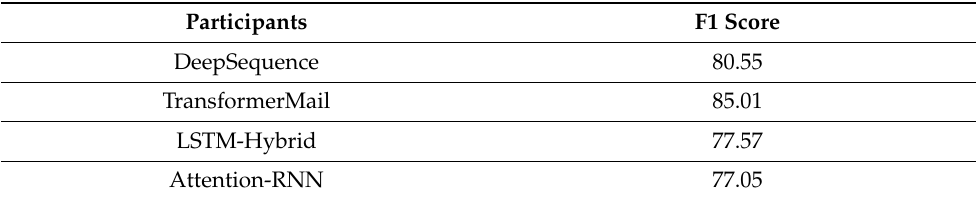
Table 4. Medical Event Extraction on i2b2/UTHealth 2010